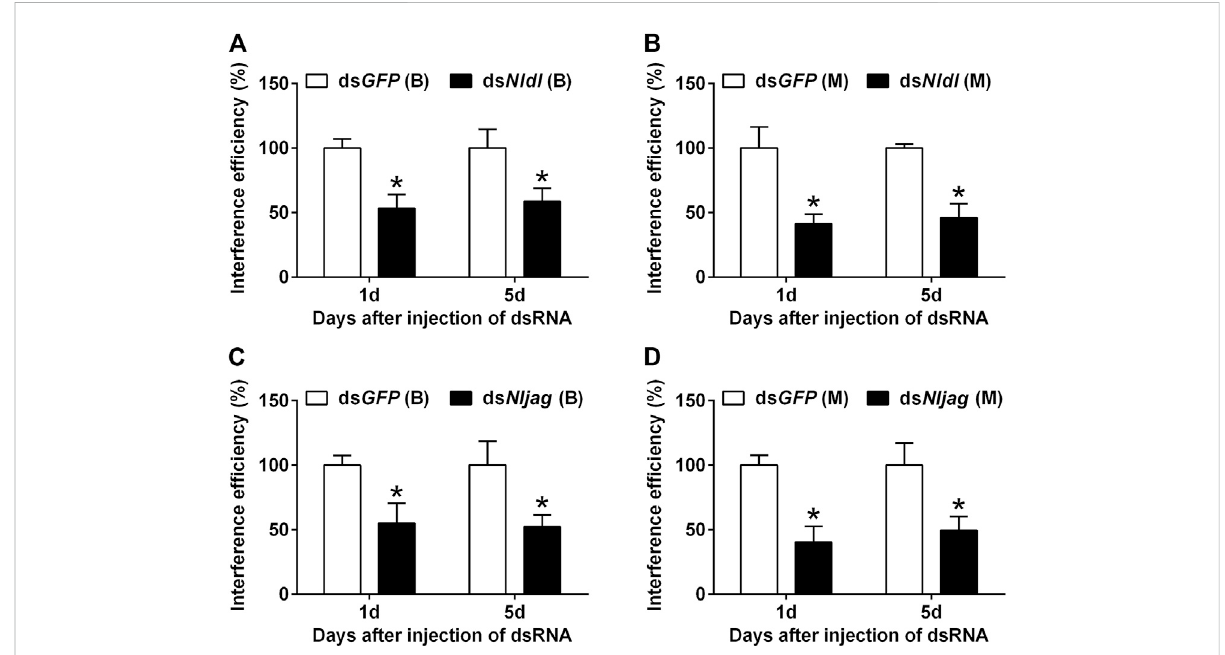
FIGURE 5 Interferenceef fi ciencyof Nldelta -RNAiand Nljagged -RNAiinBPHnymphs. (A) Interferenceef fi ciencyof Nldelta intheBrachypterousstrain. (B) Interference ef fi ciency of Nldelta in the Macropterous strain. (C) Interference ef fi ciency of Nljagged in the Brachypterous strain. (D) Interference ef fi ciency of Nljagged in the Macropterous strain. Shown are the means ± standard error of three replicates, with ten nymphs per replicate. Third- instar nymphs were injected with 25 ng ds Nldelta or 100 ng ds Nljagged . Equivalent ds GFP was used as a control. Nlactin1 was used as a housekeeping gene quantitation of relative expression levels of the test genes. Data represent the mean ± standard error ( n = 3). Asterisks